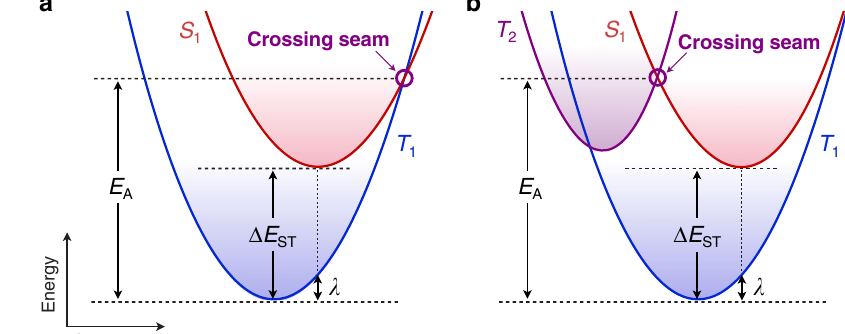
Fig. 1 RISC from triplet to singlet excited states. a , b Schematic potential energy surfaces of excited states depicting RISC via ( a ) a S 1 – T 1 crossing seam and ( b ) a S 1 – T 2 crossing